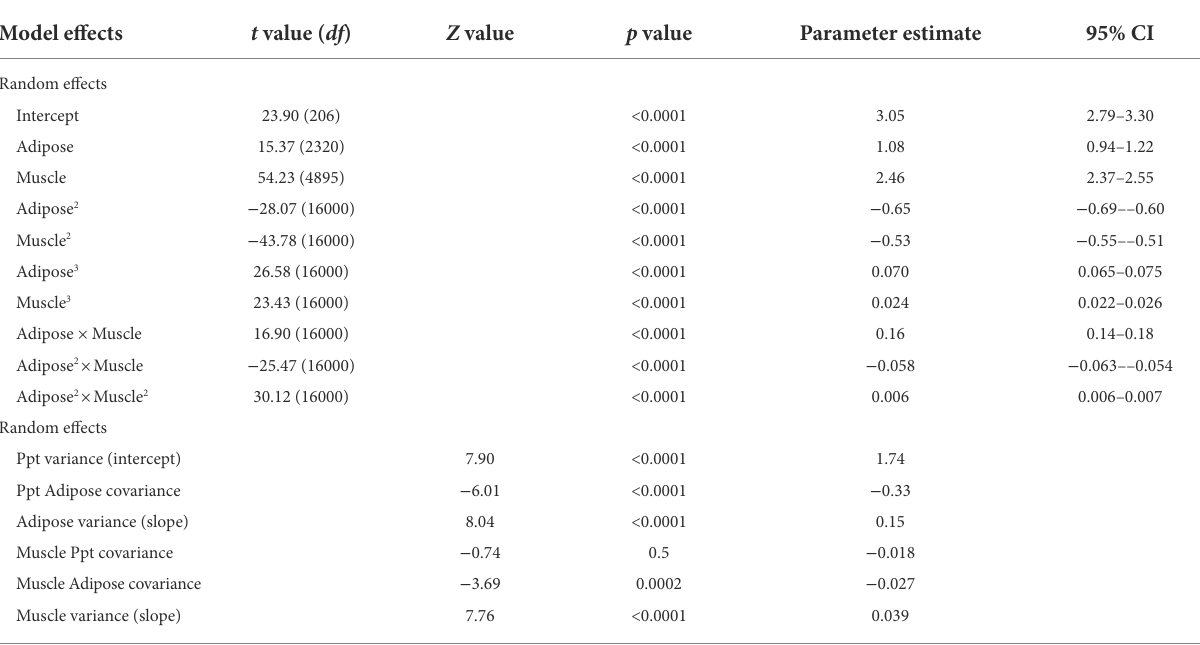
TABLE 2 Linear mixed effects model of responses to images of females.